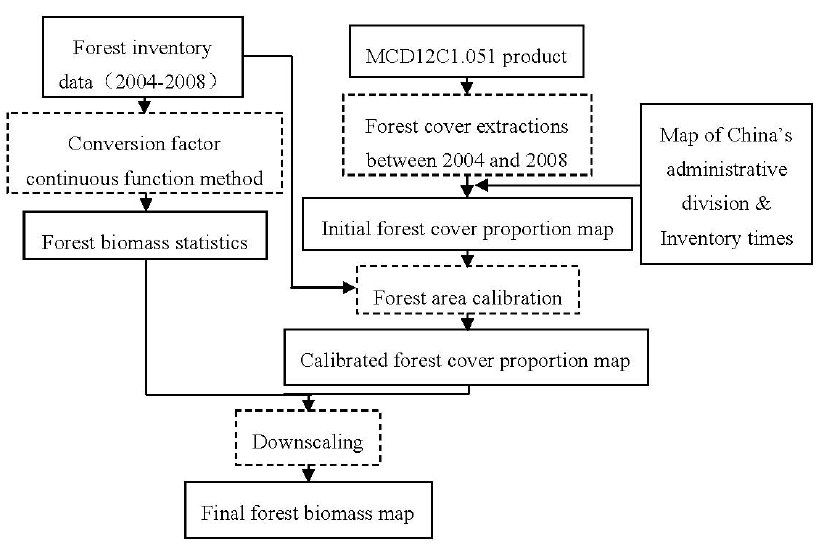
Figure 1. Flow chart for mapping forest